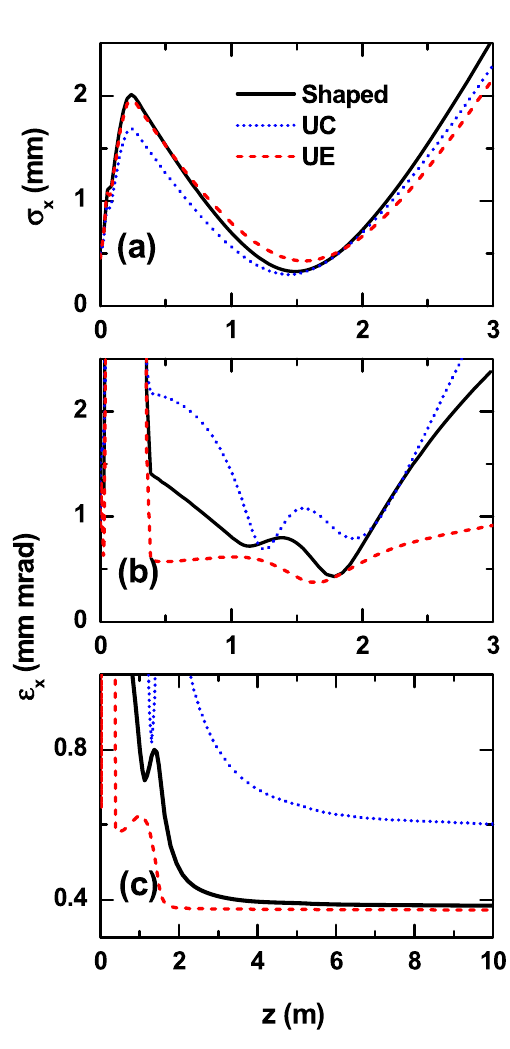
FIG. 5. (Color) (a) Transverse beam size and (b) emittance as functions of propagation distance at optimal launch phase and solenoid field without the booster linac; (c) beam emittance as a function of propagation distance with the booster linac for different laser pulse shapes. Thermal emittance is not included here.